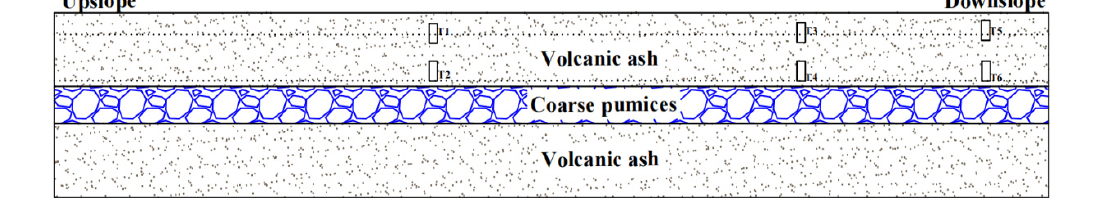
Table 1. Hydraulic properties of the materials. Figure 8. Side view of the physical model [55].